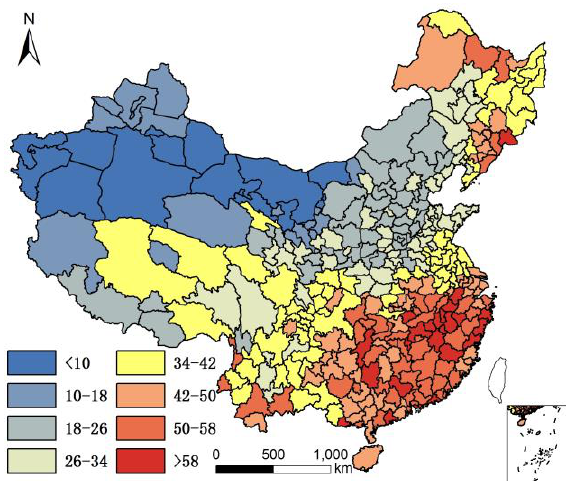
Figure 4. Standard deviation of monthly mean temperature in China.